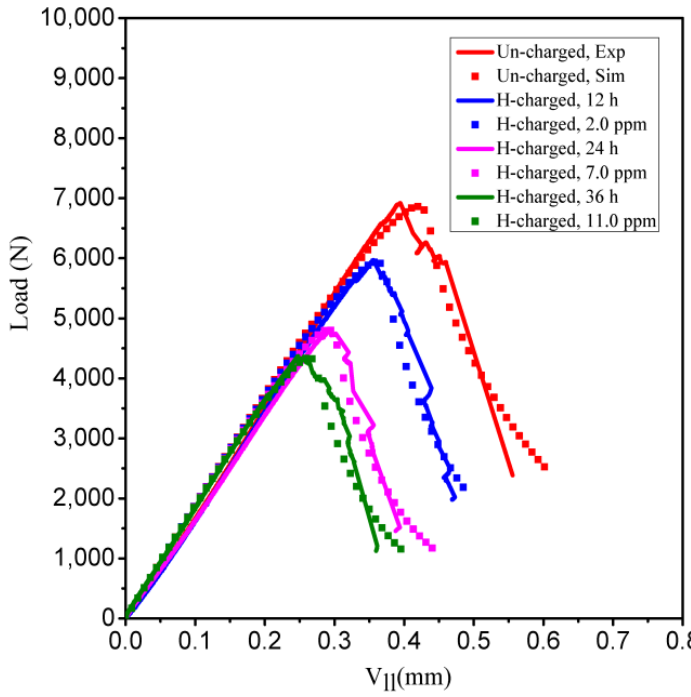
Figure 6. Load-line displacement curves for uncharged and hydrogen-charged CT specimens.